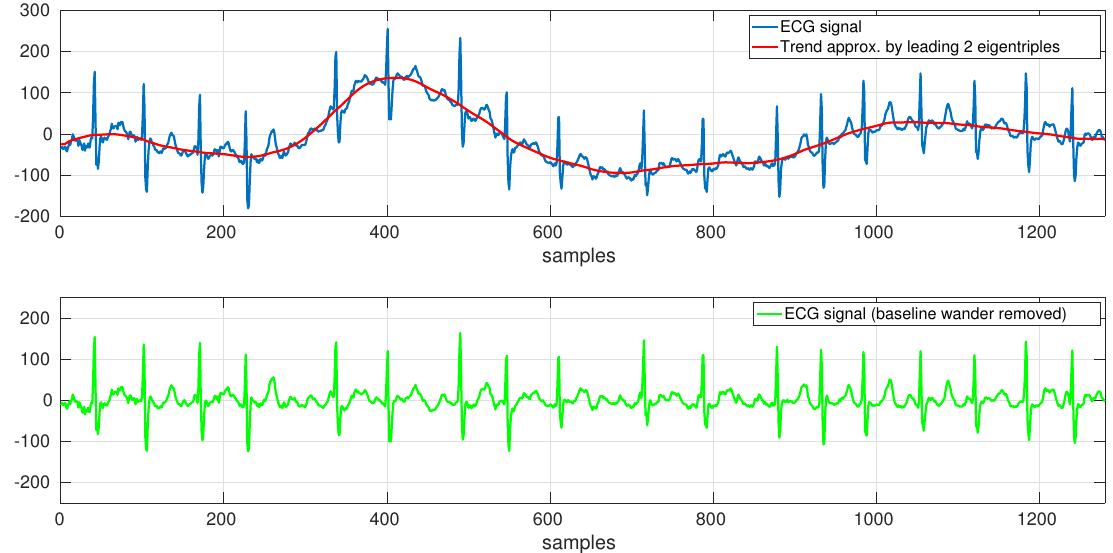
Figure 1. Application example of basic SSA: baseline wander removal. Showing excerpt 02:20–02:30 from record 14,149 m MIT-BIH ltdb